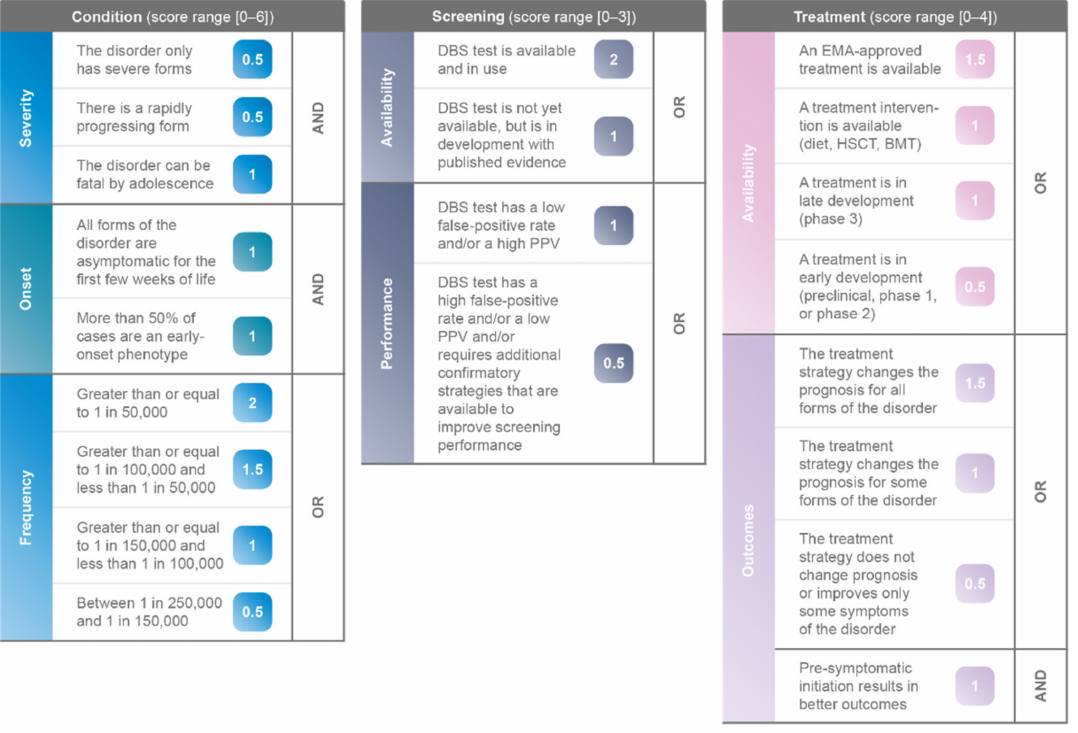
Figure 1. NBS evaluation